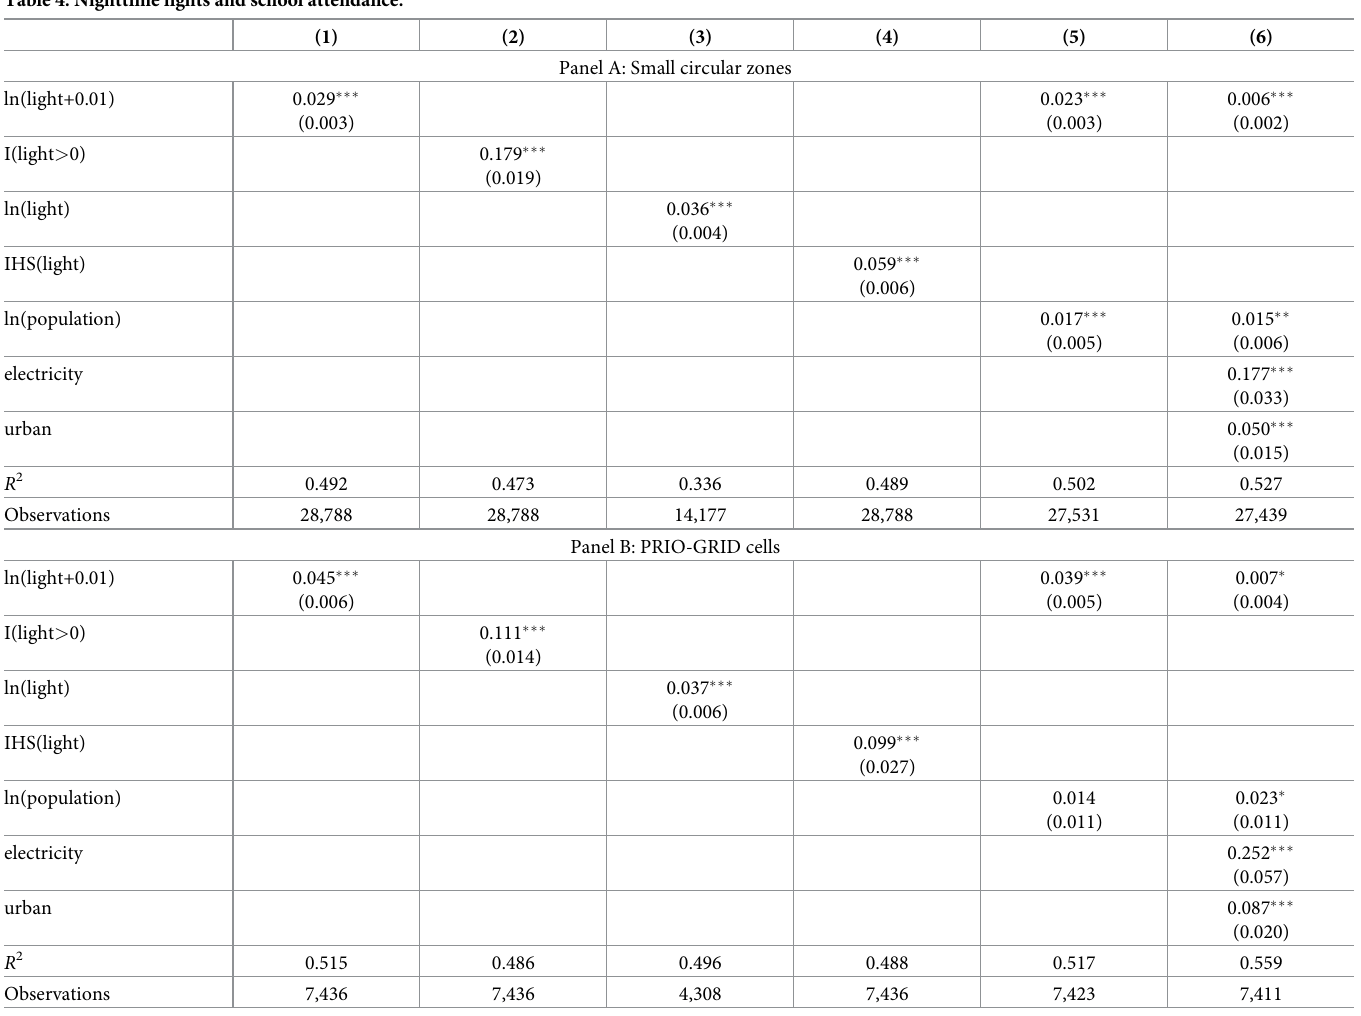
Table 4. Nighttime lights and school